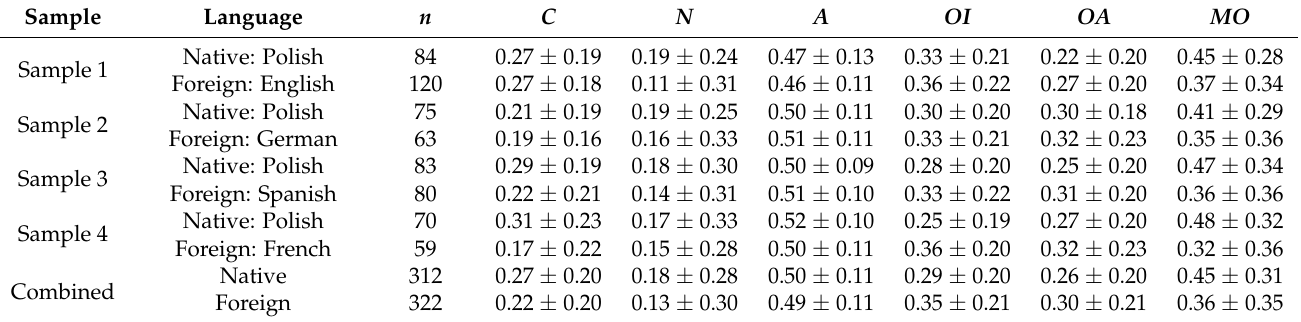
Table 2. Mean estimates and standard deviations of parameters computed with the CAN